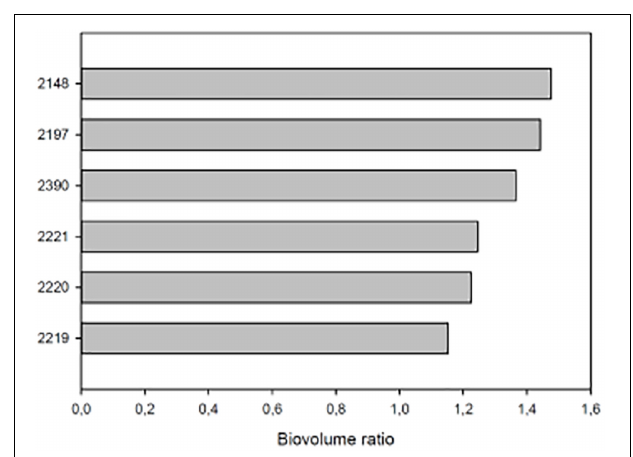
FIGURE 6 | DBR at 14 DAT of tomato plants exposed to different water limiting conditions. The UTC(70) plants were used as reference. On the Y axis each bar is identified by the number of the prototype formulation used to treat tomato plants. On the X axis the biovolume ratio. All plants were growth at 70% of the field capacity (FC) and treated with the relative prototype as indicated in Section “Materials and